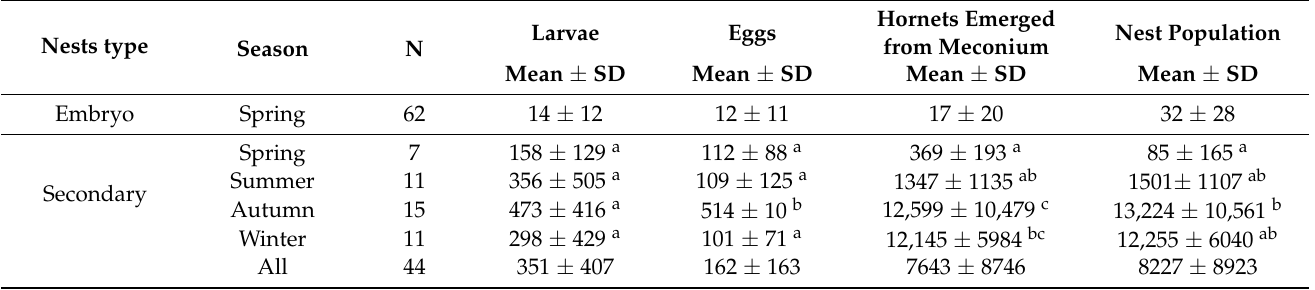
Table 2. Mean ± standard deviation (SD) of larvae, eggs, meconium larvae, and nest population of the different type of nests (embryo and secondary) classified by season when they were removed.